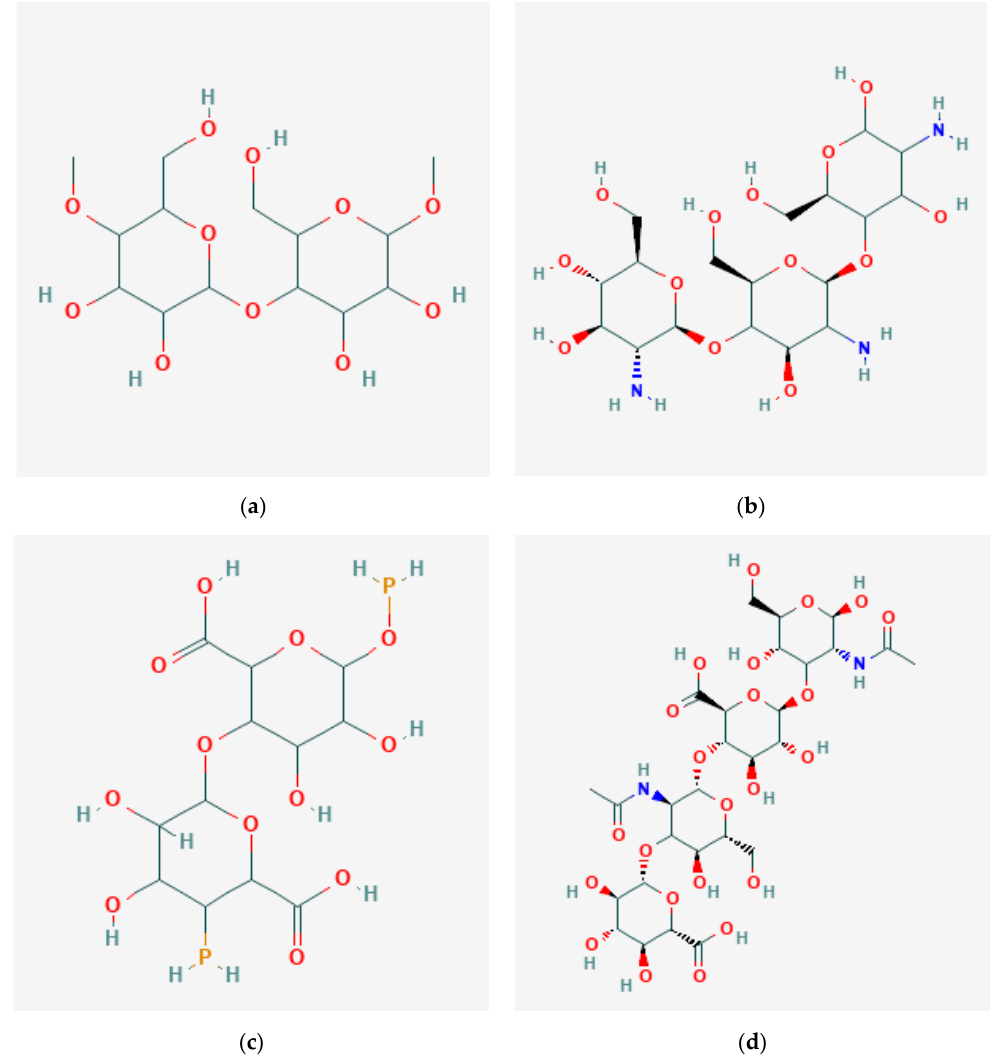
Figure 5. Molecular structure of polysaccharides: ( a ) cellulose-microcrystalline [120]; ( b ) chitosan [121]; ( c ) alginate [122]; ( d ) hyaluronic acid [123].